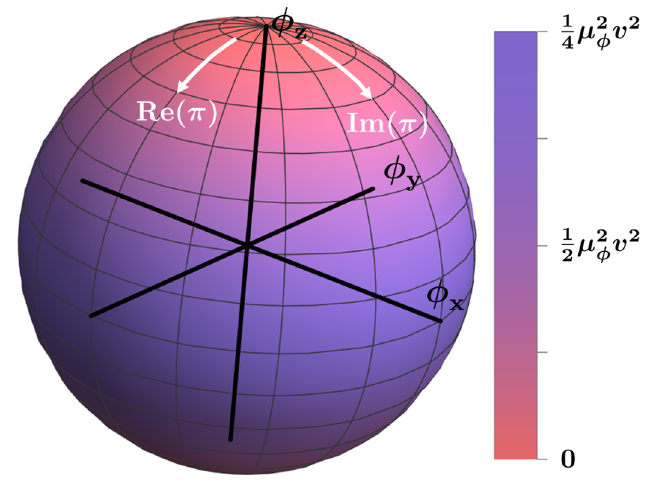
Figure 2 . The surface of φ vacua, all with magnitude | φ | 2 = v 2 , of the SO (3) -symmetric theory, colored according to the additional energy density of that field value once the µ 2 Also shown are the rotation directions corresponding to the real and imaginary parts of χ